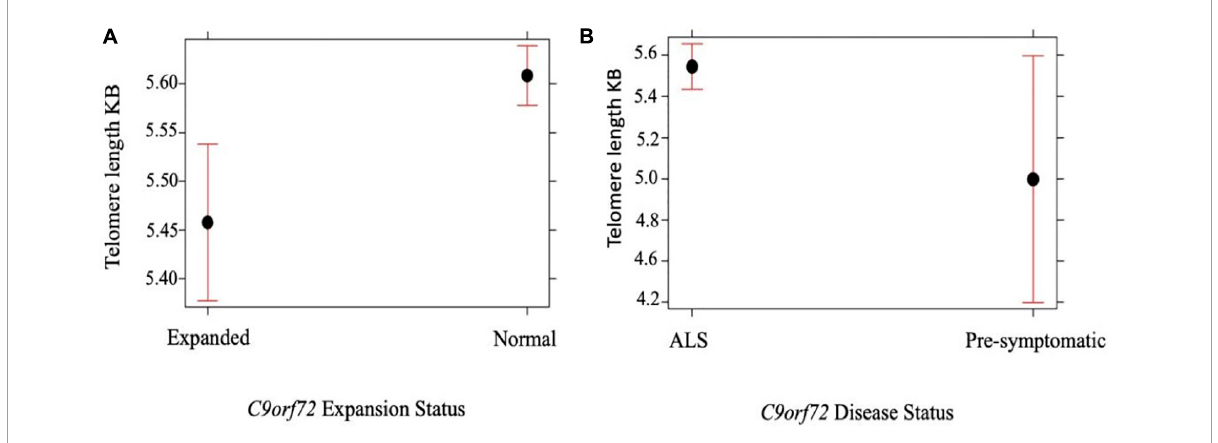
FIGURE2 (A) Telomere length comparison between 334 people with ALS carrying an expanded C9orf72 repeat against people with ALS not carrying an expansion. Multivariable linear regression shows that the telomere is shorter in those carrying a C9orf72 expansion compared with age and sex matched disease controls not carrying an expansion ( p = 5.0 × 10 - 4 ). (B) Telomere length comparison between 334 people with ALS with C9orf72 repeat expansion against 10 healthy individuals with confirmed expanded C9orf72 status. Multivariable linear regression shows that the telomere is longer in people with ALS with C9orf72 repeat expansion ( p = 0.05). Telomere length reported in kilobases (kb). Red bars indicate 95% confidence